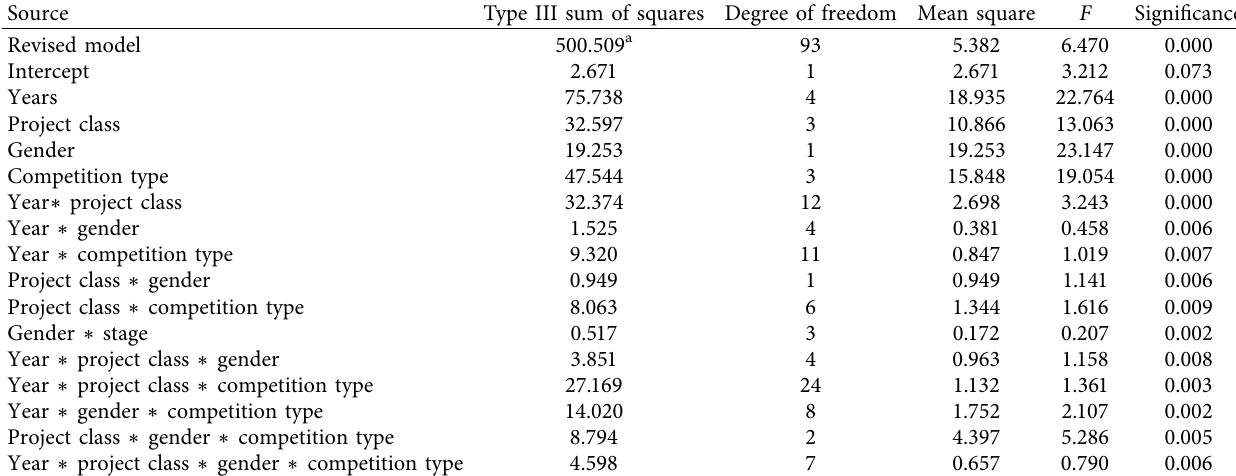
Table 4: Analysis of the difference in reaction time of athletes in different rounds of competition.